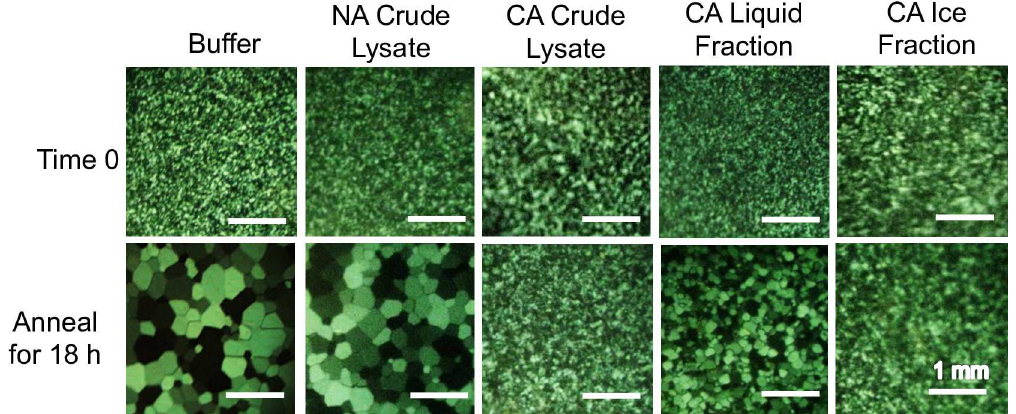
Fig 5. Monitoring ice-binding activity during ice-affinity purification of proteins from B . distachyon leaves. The crude cell lysates (0.1 mg/mL of total protein) of non-acclimated (NA) and cold-acclimated (CA) (1 week at 4˚C) leaf tissue, as well as samples collectedfrom the ice and liquidfractions duringthe purification procedurewere tested for ice-recrystallizationinhibitionactivity. Samples were observedat time 0 and followingan 18 h incubation periodat − 4˚C with all assays conductedin triplicate.